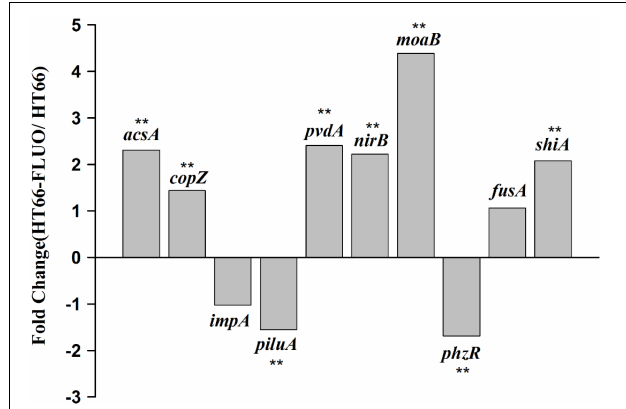
FIGURE 4 | Validation of Transcriptional data using RT-qPCR assays. Student’s t -test was carried out for the statistical analyses of the data and “ ∗∗ ” represents statistically significant difference at p <